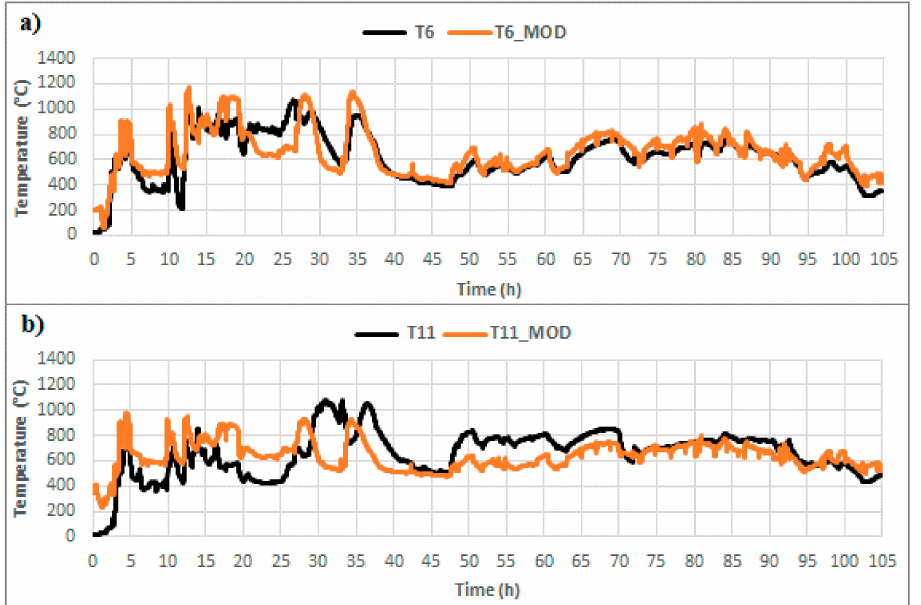
Figure 15. The measured (T) and modeled (T_MOD) temperature behavior, ( a ) temperature T 16 , ( b ) temperature T 11 (Source: own elaboration).